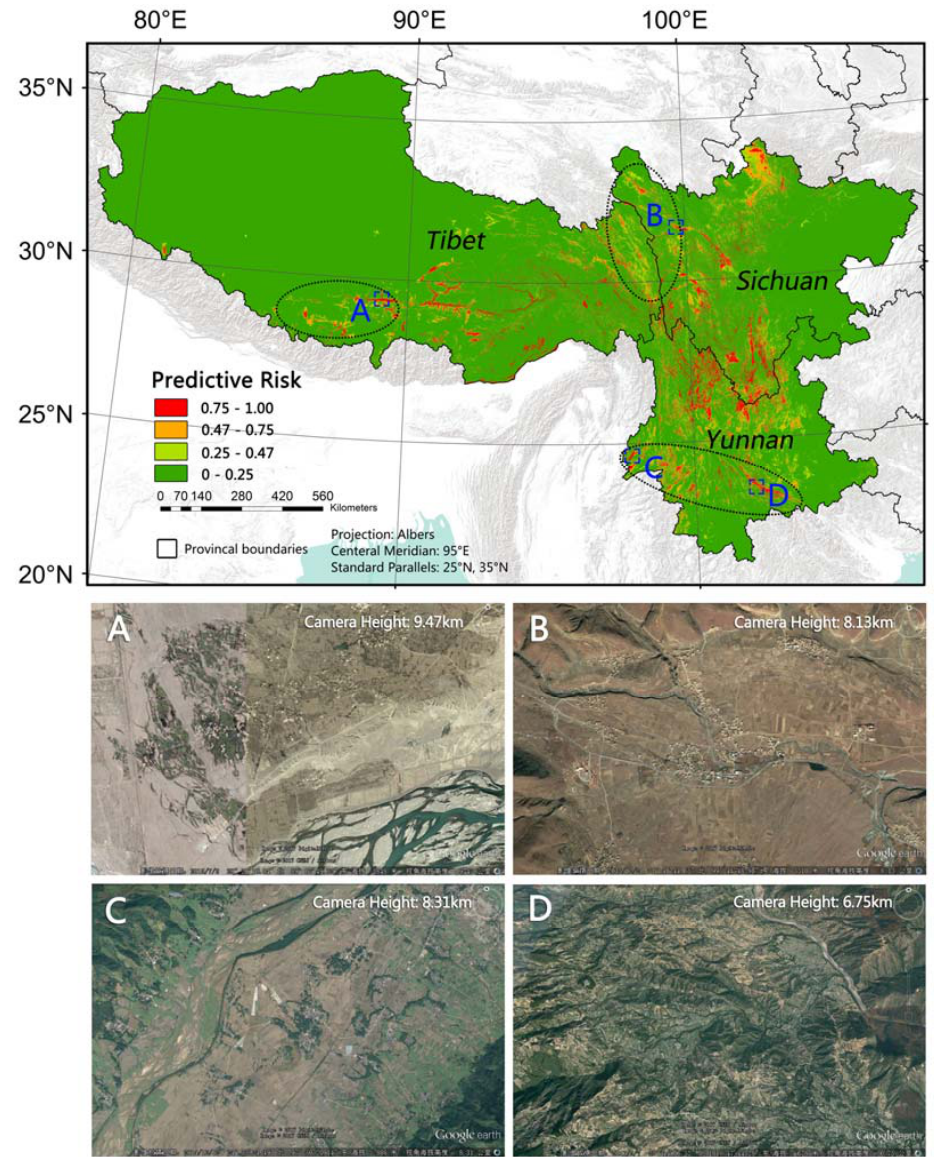
Figure 4. Predicted high ‐ risk patches in non ‐ hotspot regions. ( A – D are four examples of predicted high ‐ risk patches in non ‐ hotspot region. Residents in site A , B and C live in river valleys, residents in site D live on rugged lands. The four images are Google Earth images in corresponding sites showing the poor living conditions).